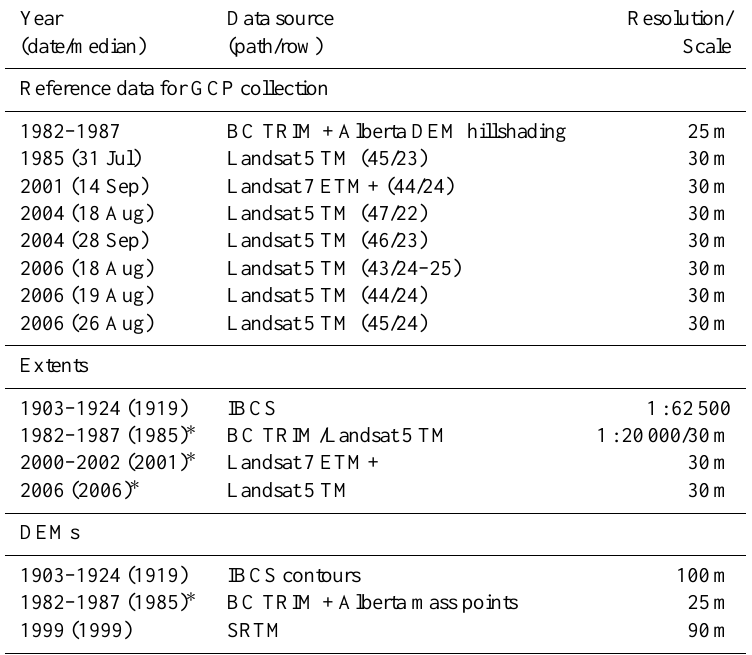
Table 1. Data used to rectify the IBCS maps and to assess glacier change between 1919 and 2006.